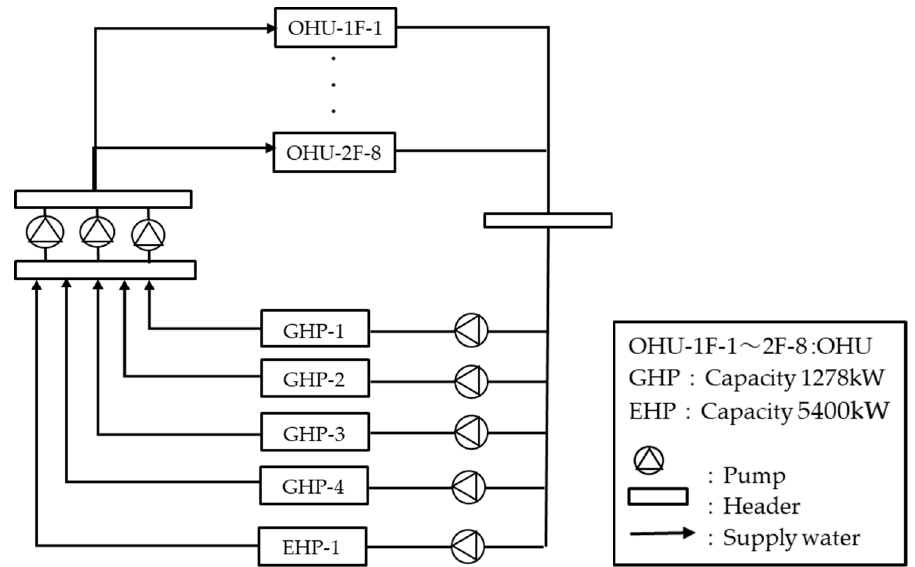
Figure 4. Configuration of heat source system.